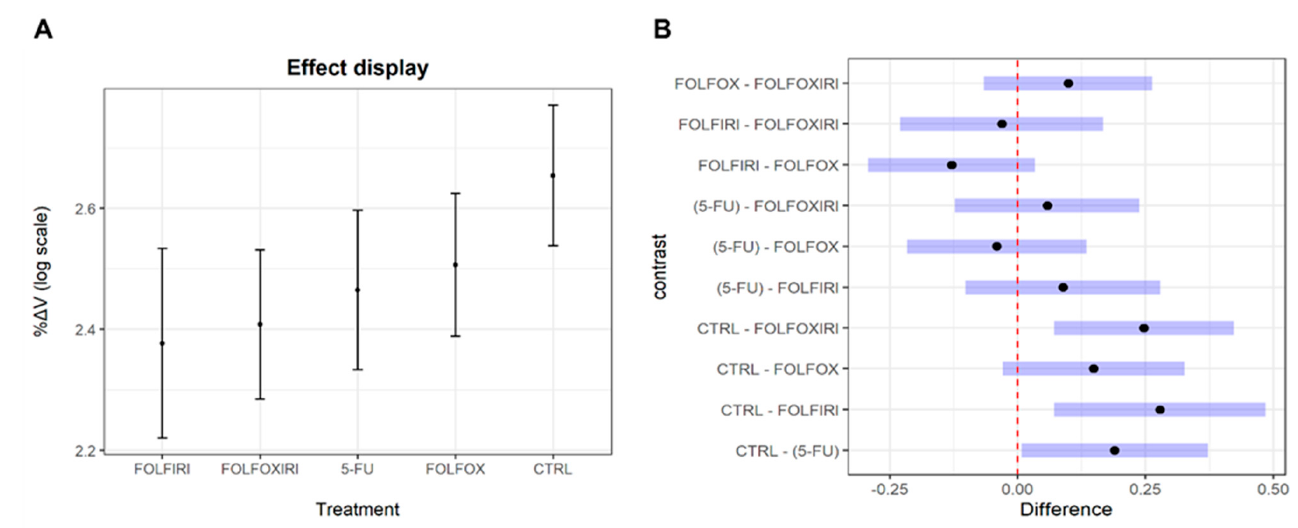
Figure 1. LMM results. ( A ) Effect displays. Treatments are on the x -axis. Dots represent the fixed effect coefficients of % Δ V on log scale estimated by the LMM. The bars are the 95% CIs of fixed effect coefficients. ( B ) Post-hoc test results. Differences of marginal means are on the x -axis and pairwise comparisons between treatments are displayed on the y -axis. Blue bars represent the 95% CIs of marginal means differences estimated through R package emmeans. The dashed line corresponds to a difference of zero between means.